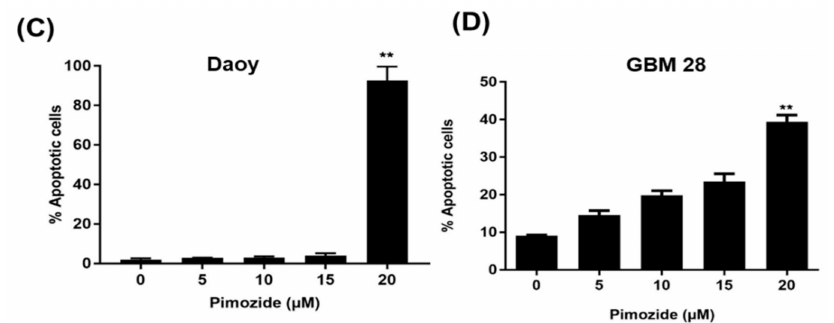
Figure 4. Pimozide induces apoptosis in brain tumor cells in a concentration-dependent manner. Approximately 0.2 × 10 6 of ( A ) U-87 MG, ( B ) U-251 MG, ( C ) Daoy, and ( D ) GBM 28 cells were plated in six-well plates, treated with 5, 10, 15, and 20 µ M pimozide for 48 h and processed for AnnexinV / FITC apoptosis assay using a BD FACSverse flow cytometer. Values were plotted as mean ± SD. The experiment was repeated three times. * Statistically significant at p ≤ 0.05 when